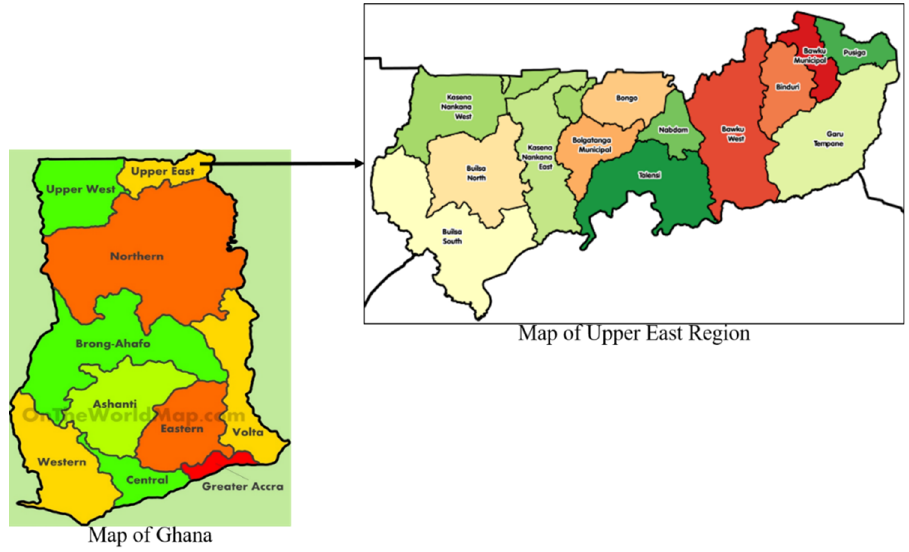
Figure 1. Study Figure 1. Study setting.